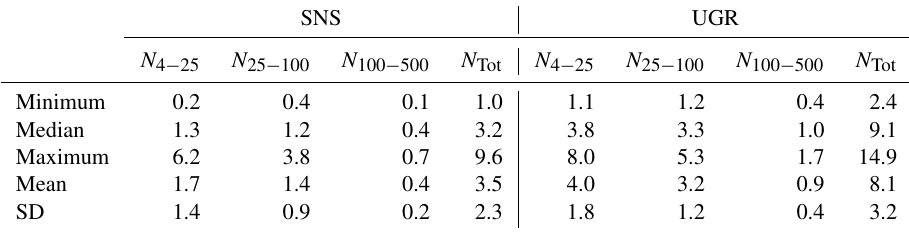
Table 1. Statistical overview of daily aerosol concentrations in different size ranges in 10 3 cm − 3 at the SNS and UGR station.